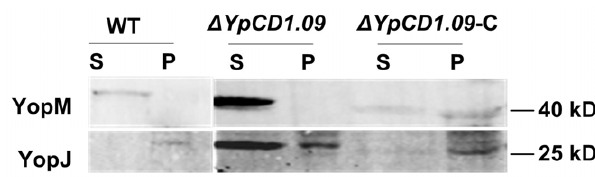
Figure 2. Analysis of YopJ and YopM secretions in the D YpCD1.09 mutant. Bacterial strains were inoculated into TMH without calcium and incubated at 26 u C to an OD600nm of 1.0. The bacterial cultures were then transferred to 37 u C for 3 hours incubation to induce the Yops expression and secretion. Proteins from the culture supernatant (S) and the cell pellets (P) were separated by SDS-PAGE electrophoresis and detected using rabbit polyclonal antibodies against YopJ and